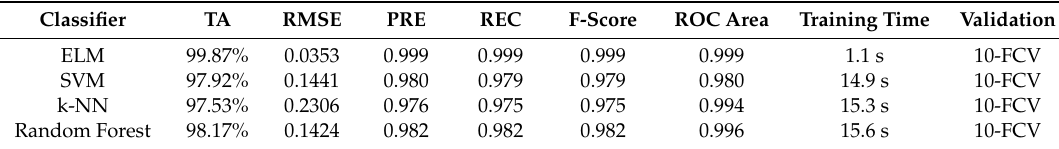
Table 3. Algorithm comparison providing classification accuracy and performance